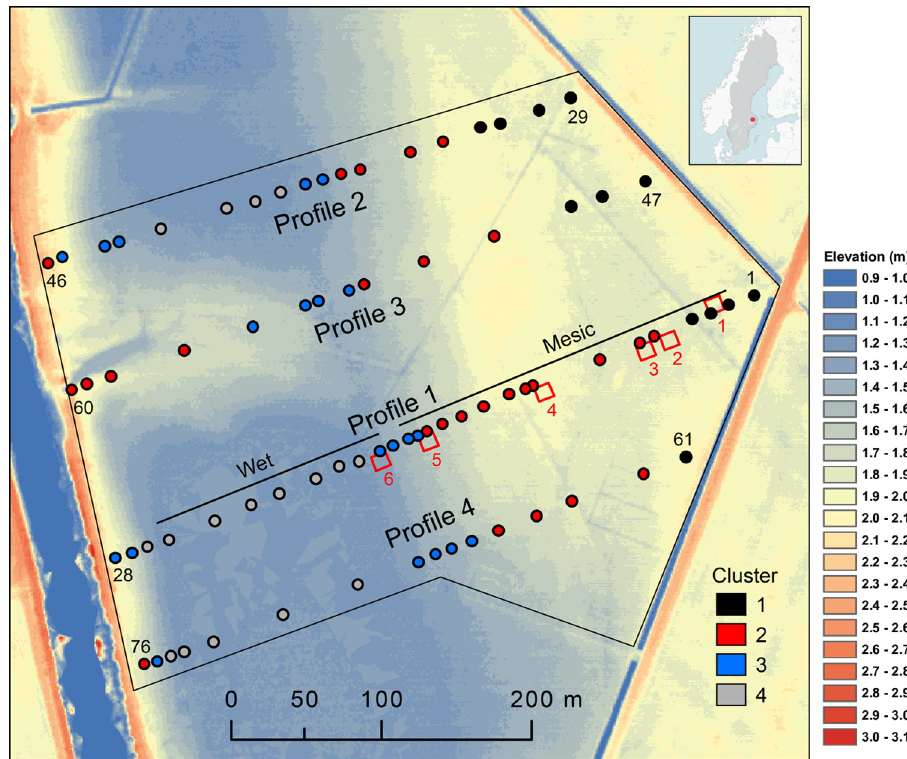
Fig 1. Kungsa¨ngen nature reserve with the River Fyris å n to the left. Vegetation plots (2 m × 2 m) were placed along four profiles (Profile 1 followed since 1940, Profiles 2–4 since 1982), colours identify the four vegetation clusters identified in 1982. For profile 1, the Wet and Mesic parts identified in 1940 are indicated. Flowering Fritillaria meleagris were counted in six plots, 1–6, (red squares, 10 m × 10 m). Background colours show elevation based on laser scanning with 1 m grid (Markho¨jdmodell grid 1+) from Lantma¨teriet (the Swedish Land Survey, www.lantmateriet.se). Plot elevation varies between 1.2 and 2.2 m a.s.l. Inset shows location in Sweden. The area treated by rotor cultivator in the 1990s roughly corresponds to Cluster